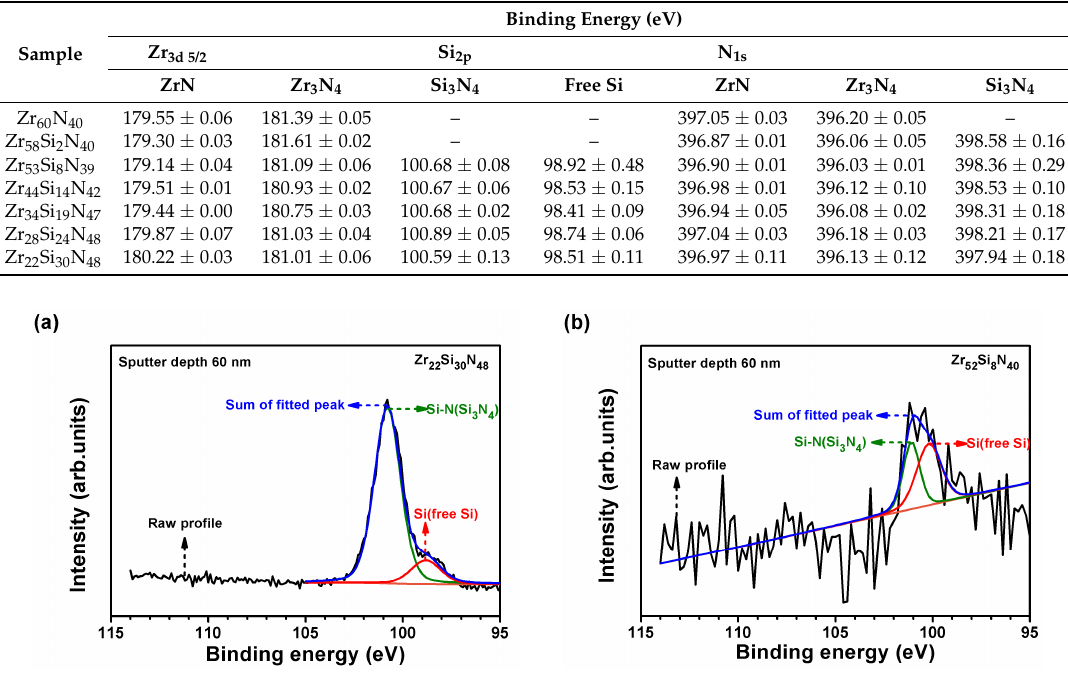
Figure 7. XPS profiles of Si 2p core levels of ( a ) Zr 22 Si 30 N 48 (0.4,R5) and ( b ) Zr 52 Si 8 N 40 (0.4,R5) coatings at a depth of 60 nm.